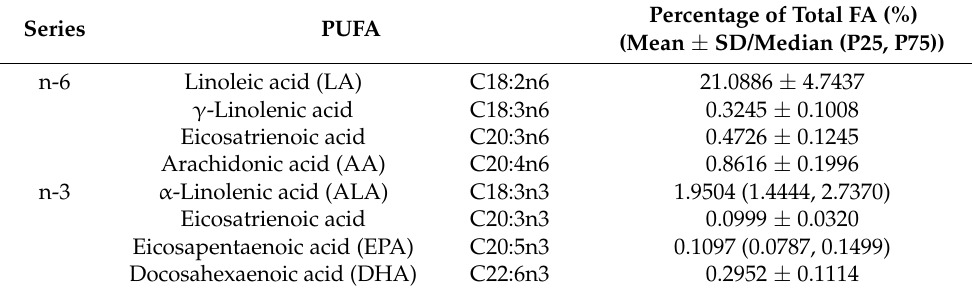
Table 3. PUFA profile of breast milk in this study.